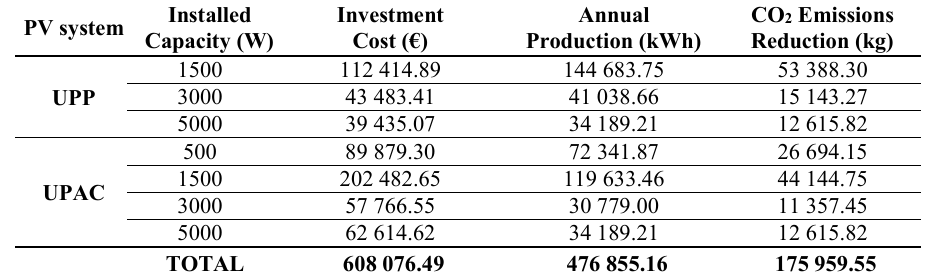
Table 5. E3 Impacts - Aggressive